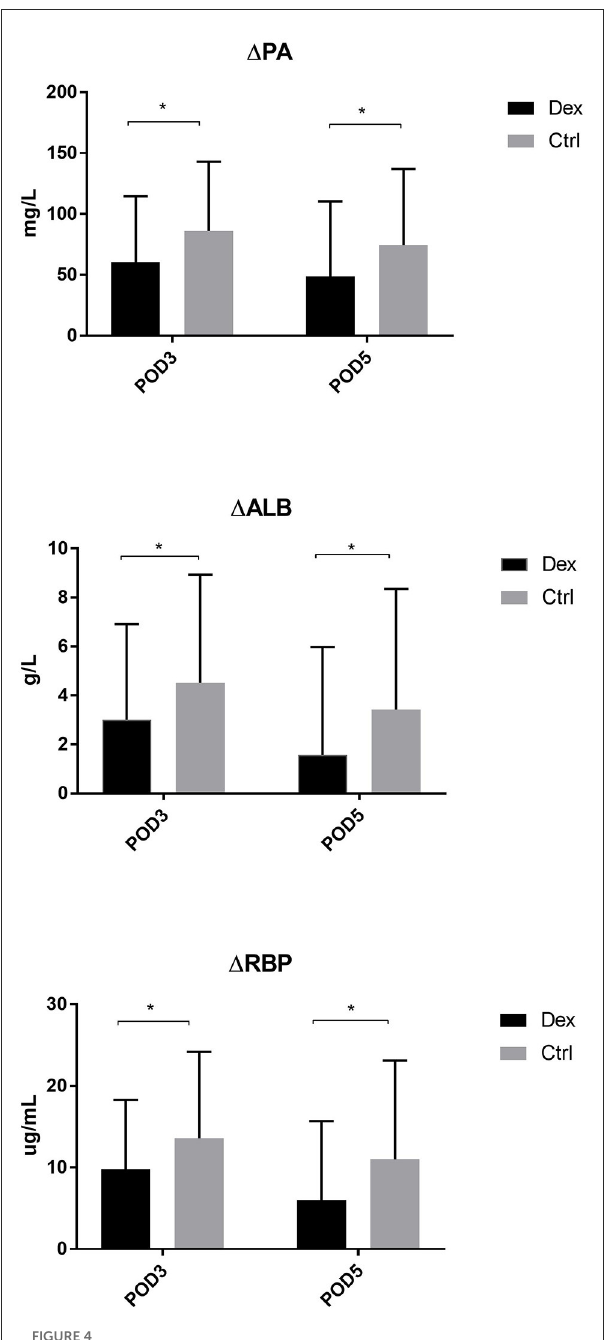
FIGURE4 The decrease of PA, ALB, RBP in POD3 and POD5. 1 represents the difference between preoperative value and postoperative value. * P < 0.05.